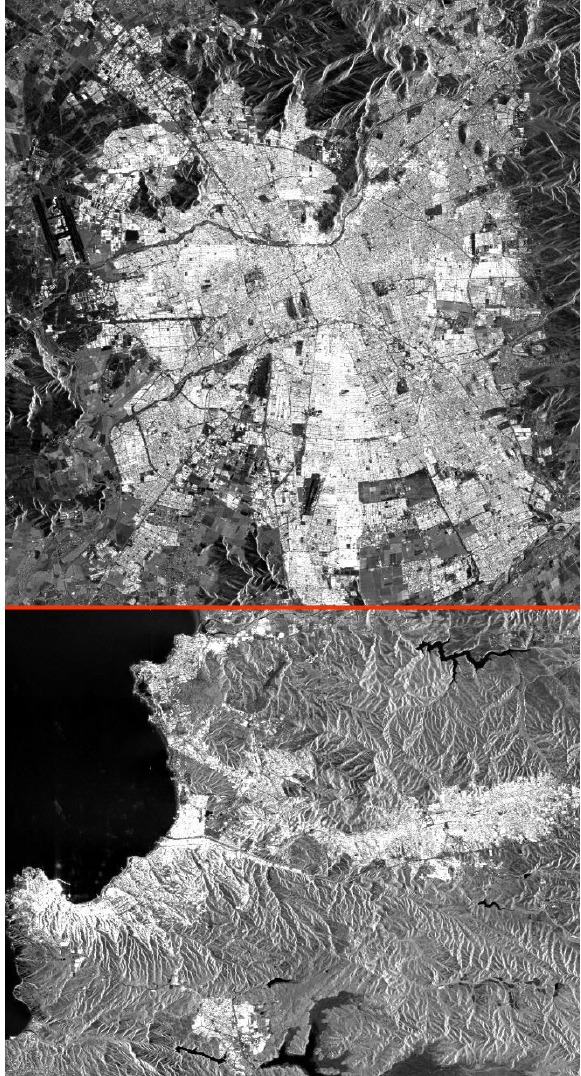
Figure 1. (up) mean amplitude image of Santiago (bottom) mean amplitude image of